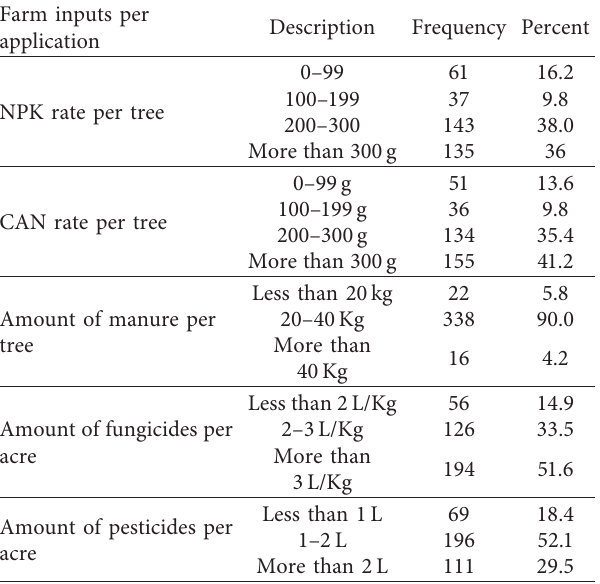
Table 3: Descriptive statistics for fertilizer and manure application rates.